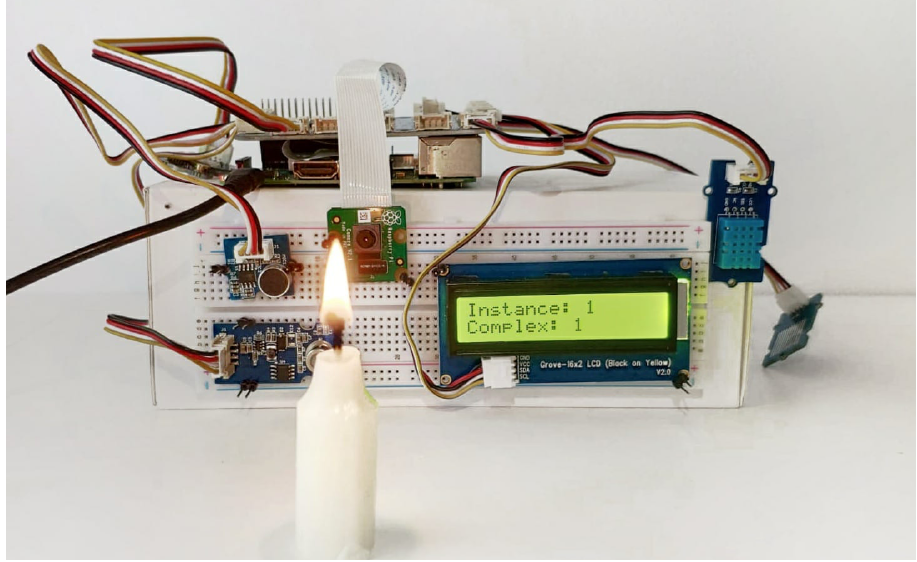
Figure 6. The experimental EDU when detecting 1 instance event (noise) and 1 complex event (fire).